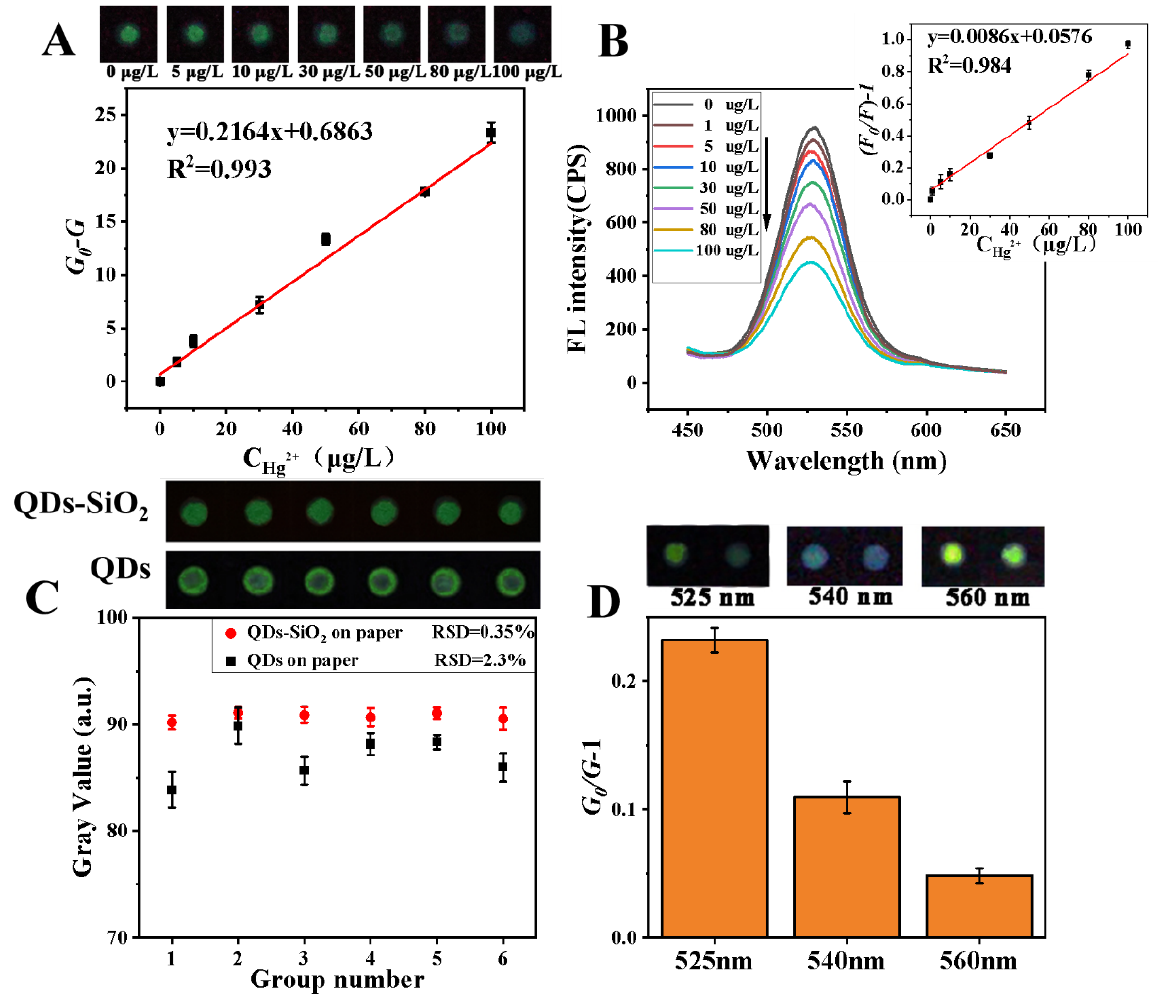
Figure 4. ( A ) Photograph of the color change of the quenching effect of Hg 2+ on the paper-based QDs–SiO 2 and its corresponding linear curve with linear equation. The concentrations of Hg 2+ were 0, 5, 10, 30, 50, 80 and 100 µ g/L. ( B ) Fluorescence spectral response diagrams of the quenching effect of Hg 2+ on paper-based QDs–SiO 2 and its corresponding linear curve with linear equation. The concentrations of Hg 2+ were 0, 1, 5, 10, 30, 50, 80 and 100 µ g/L, the excitation wavelength was 396 nm and the slit widths were 5 nm. ( C ) The gray values of six different sensing sites with QDs–SiO 2 and QDs. ( D ) The influence of the different emission wavelengths of QDs on the quenching effects, where the Hg 2+ concentration was 50 µ g/L (n =